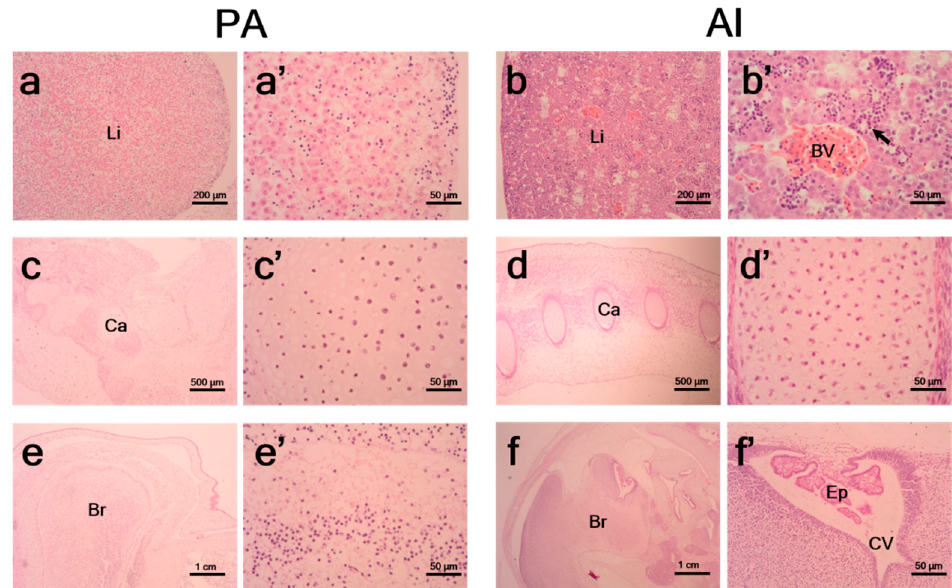
Figure 4. Histopathological analysis of PA and AI fetuses at day 35. Histopathological examination of developing livers ( a , b ), cartilage ( c , d ), and brains ( e , f ) were conducted on PA and AI fetuses at day 35 after embryo transfer. Black arrow indicates primitive hematopoietic cells in a liver section ( b’ ). BV: blood vessel; Ca: cartilage; Br: brain; Ep: ependymal cell; CV: cerebral ventricle.